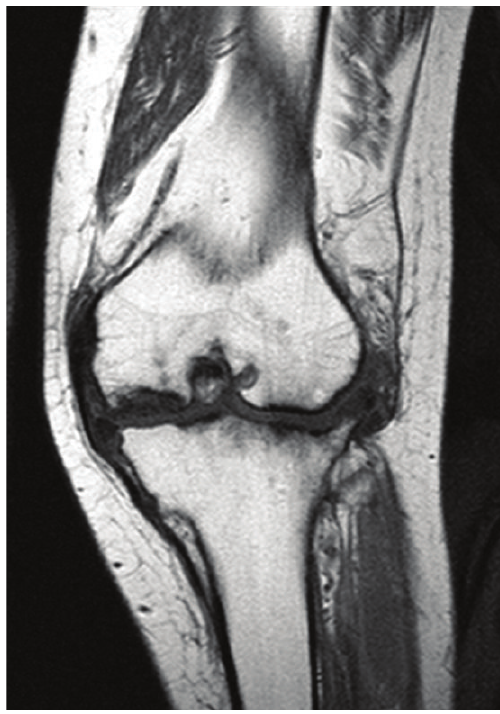
Figure 7: MRI T1 coronal view of the left knee.